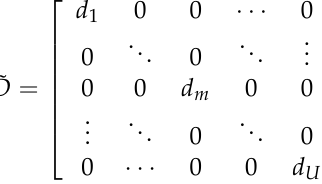
Figure 2 represents the degree of one frame clutter graphs from the land and sea datasets.